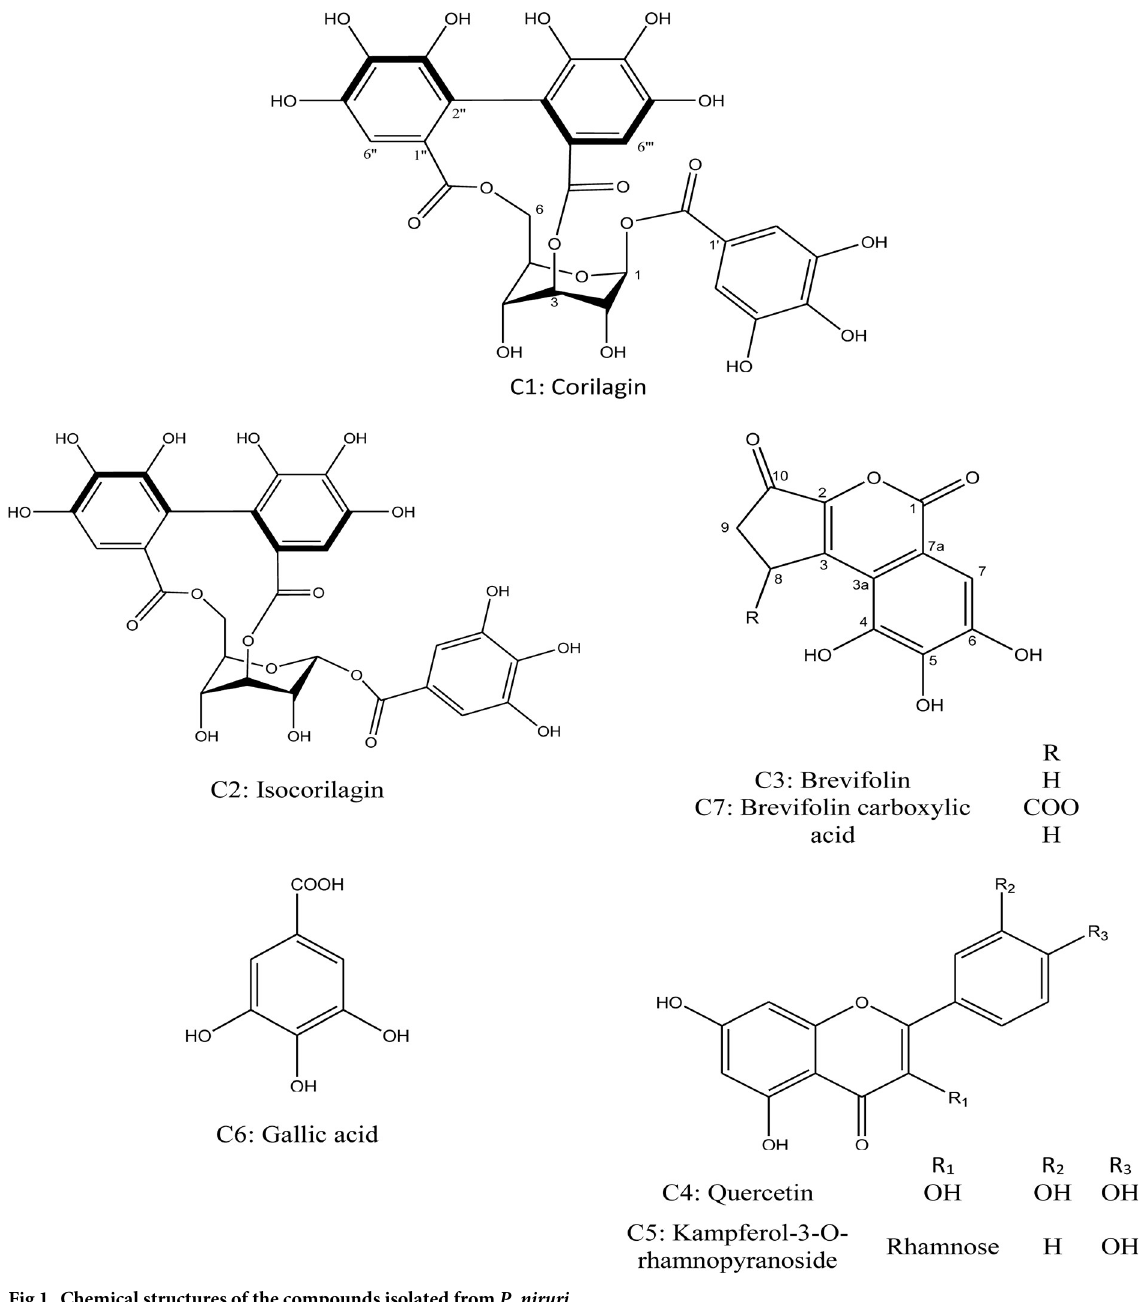
Fig 1. Chemical structures of the compounds isolated from P . niruri